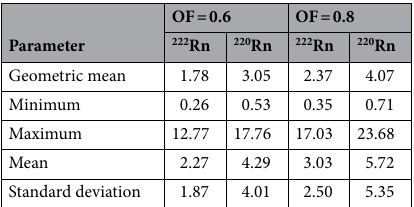
Table 3. Annual effective dose due to inhalation of radon and thoron (mSv y −1 ) with occupancy factors (OF) = 0.6 and